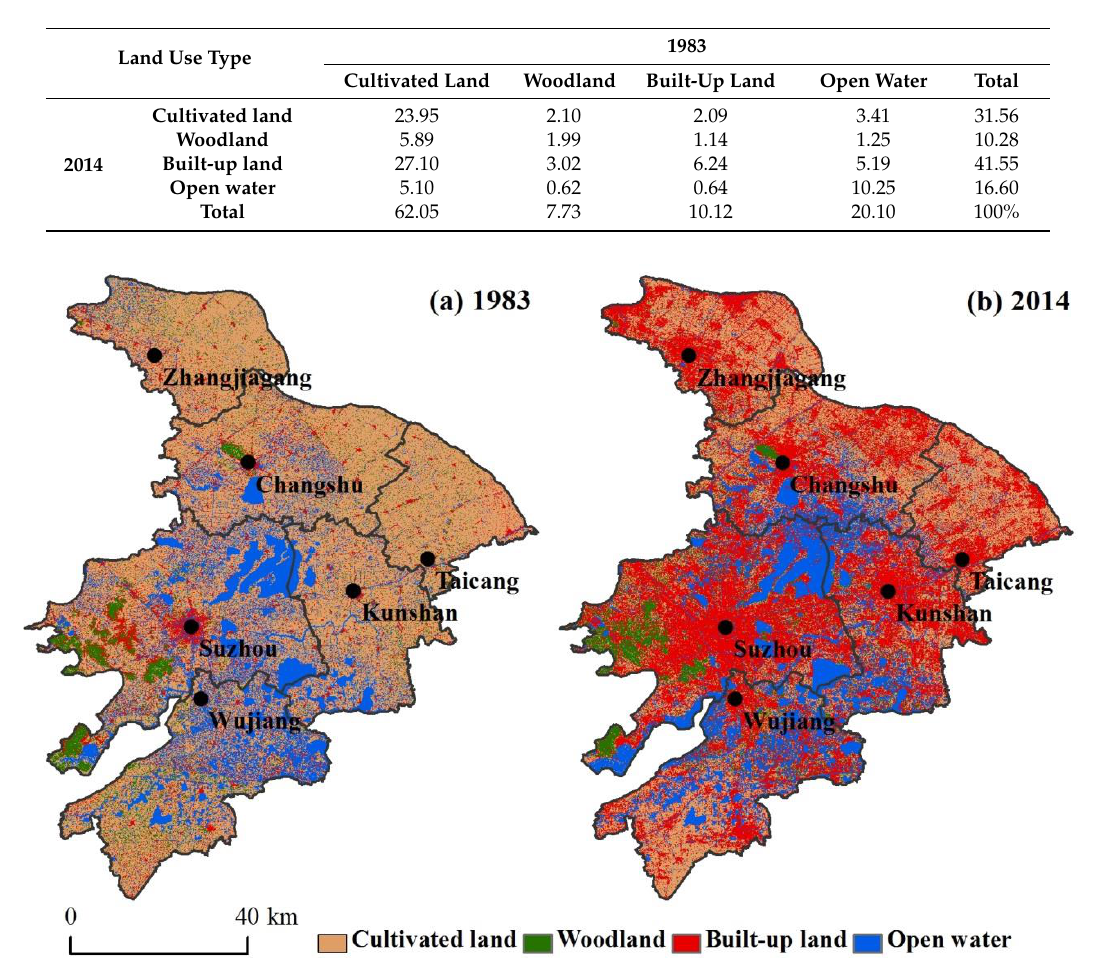
Figure 3. Land use maps of the study area in 1983 ( a ) and 2014 ( b ) at a 30-m resolution.